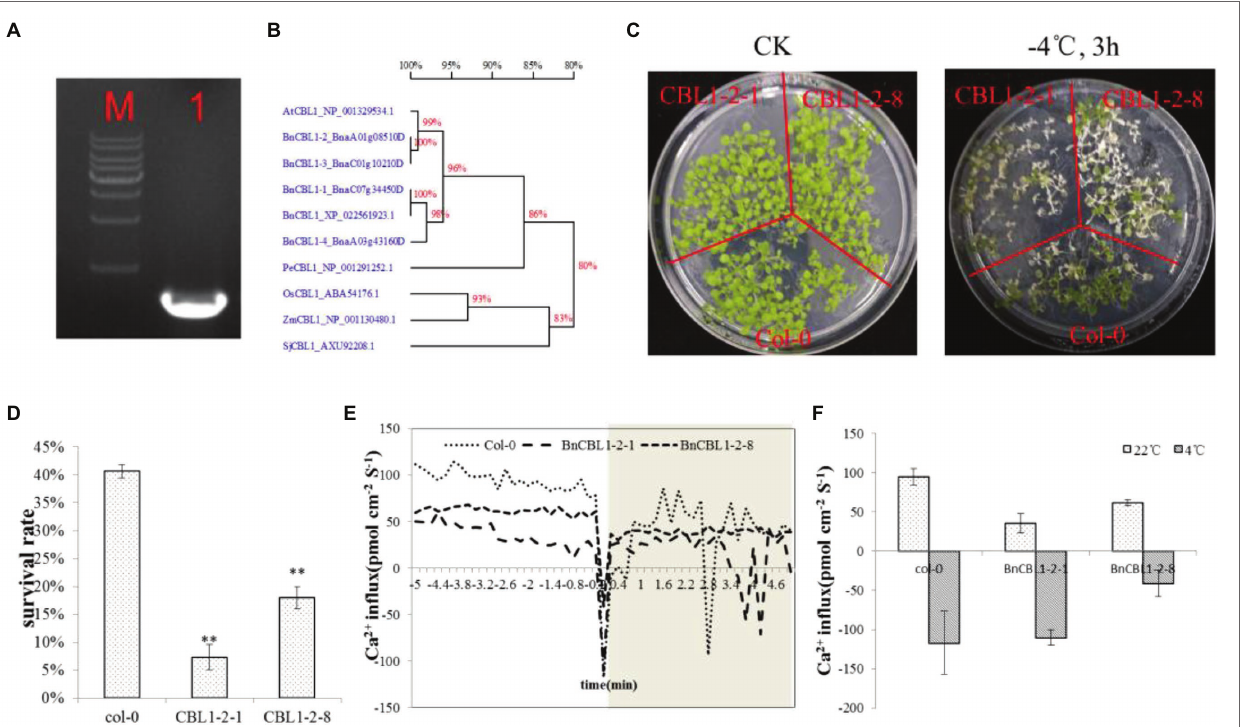
FIGURE 5 | BnCBL1-2 reduced cold tolerance and Ca 2+ flux. (A) Cloning of BnCBL1-2 , M: 1 Kb Maker, 1: 642 bp; (B) Phylogenetic relationships of CBL1 genes in plants; (C) The phenotype of Col-0 and BnCBL1-2 -overexpressing Arabidopsis lines under 22 ° C and − 4 ° Ctreatment; (D) The survival rate of Col-0, CBL1-2-1 , and CBL1-2-8 after 3 h of − 4 ° C freezing stress; (E,F) Ca 2+ influx under Cold Shock in col-0 and overexpressing BnCBL1-2 Arabidopsis. (E) NMT measurements show extracellular Ca 2+ influx upon on cold shock in live leaves of col-0 and overexpressing BnCBL1-2 Arabidopsis ( n = 3). (F) the mean Ca 2+ fluxes in 22 ° C and 4 °